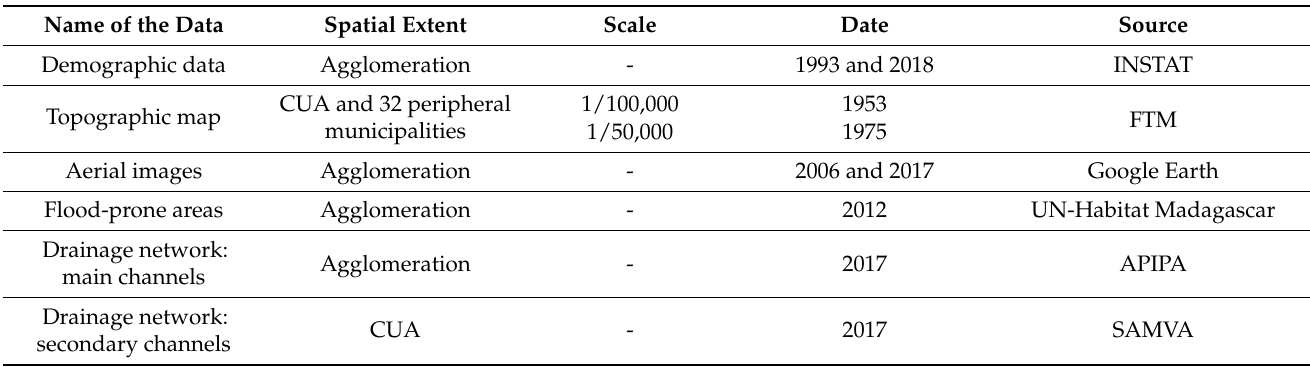
Table 1. Data used in the analysis. INSTAT, Institut National de la Statistique de Madagascar; FTM, Foiben-Taosarintanin’i Madagasikara; APIPA, Autorit é pour la Protection contre les Inondations de la Plaine d’Antananarivo; SAMVA, Service Autonome de Maintenance de la Ville